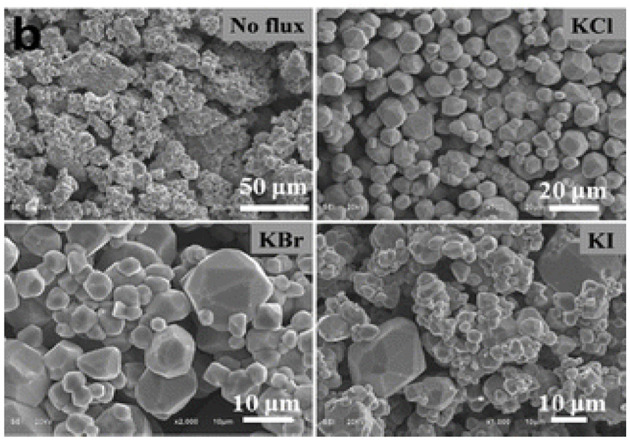
The influence of different fluxes on the size and shape of CoS2 particles. Reproduced from Wang et al. (2012) with permission of American Chemical Society.